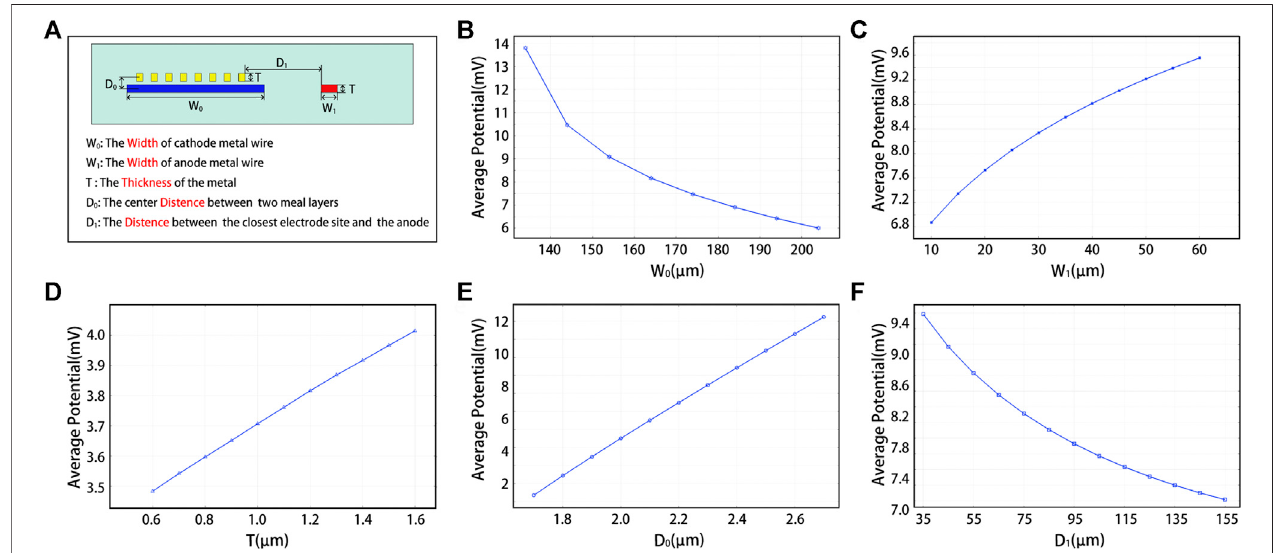
FIGURE4|(A) Theschematicdiagramofvarious parameterde fi nitions. (B – F) Therelationshipbetweentheaveragepotentialofeightelectrodesand (B) thewidth of cathode metal. (C) the width of anode metal. (D) the thickness of the metal layer. (E) the center distance between the μ LED metal layer and the electrode metal layer. (F) the edge-to-edge distance between the anode and the electrode